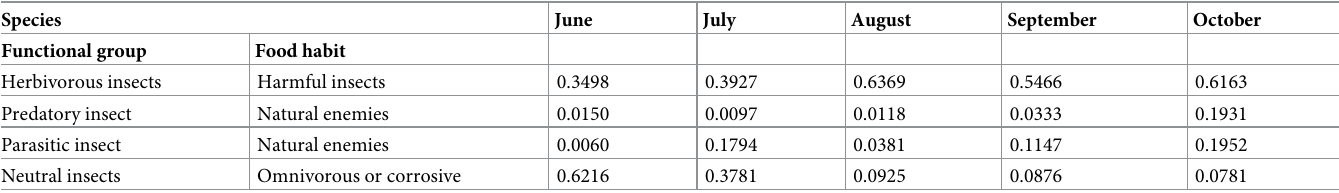
Table 2. Ecological dominance of functional groups of farmland insect communities.